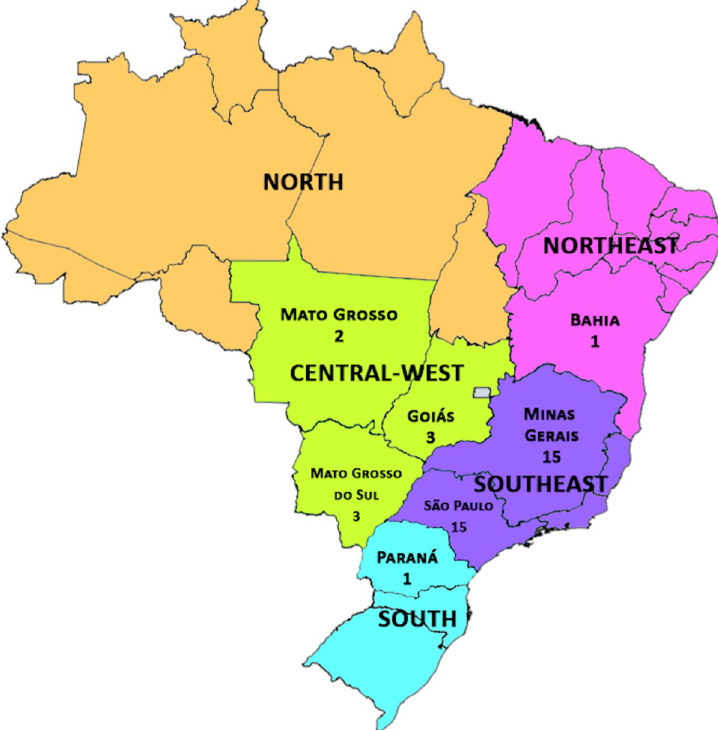
Fig 5. Brazilian map depicting the birthplace of patients with the R337H mutation (numbers in the map describe the number of patients with the R337H mutation who came from that specific state).